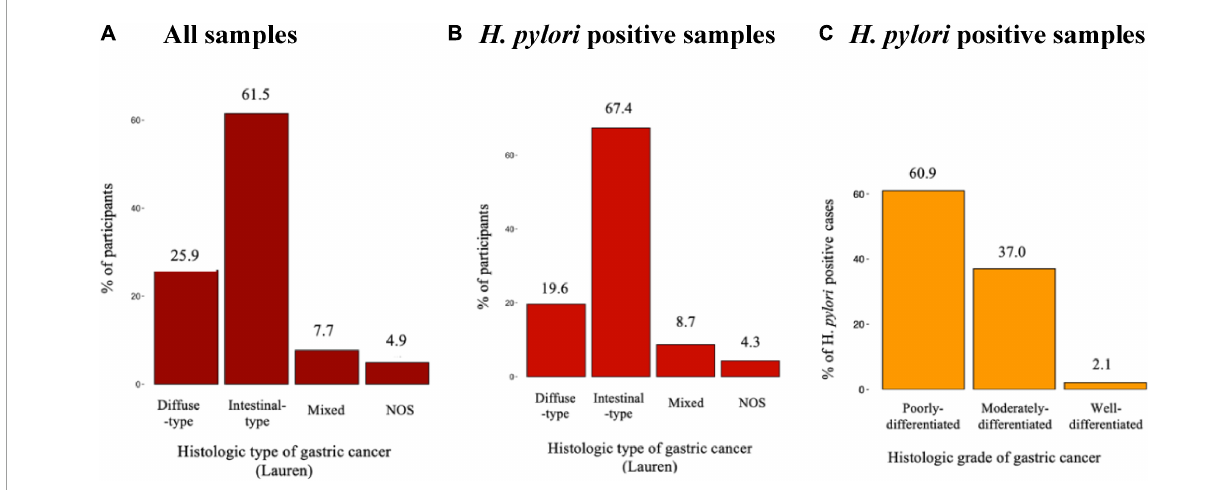
FIGURE1 Distribution of Helicobacter pylori amongst the histologic types and grades of gastric adenocarcinoma. (A) All samples, (B) H. pylori positive samples, and (C) H. pylori positive samples.